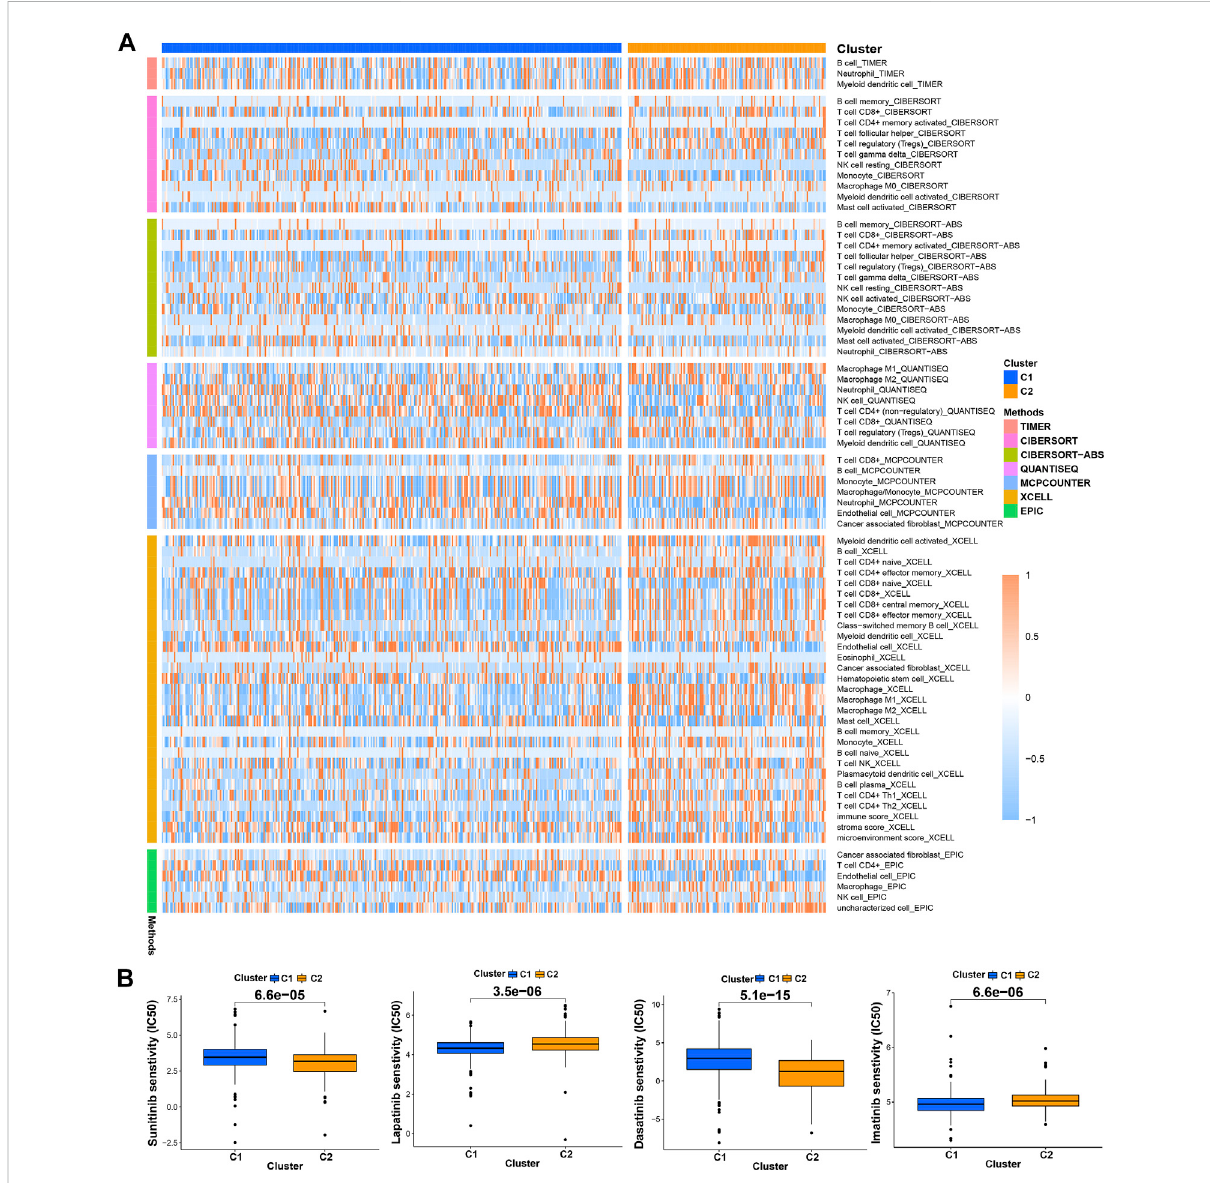
FIGURE 9 Distinction between risk groups and clusters. (A) The heatmap of immune cells in clusters from different platforms; (B) some of the drug sensitivity prediction of